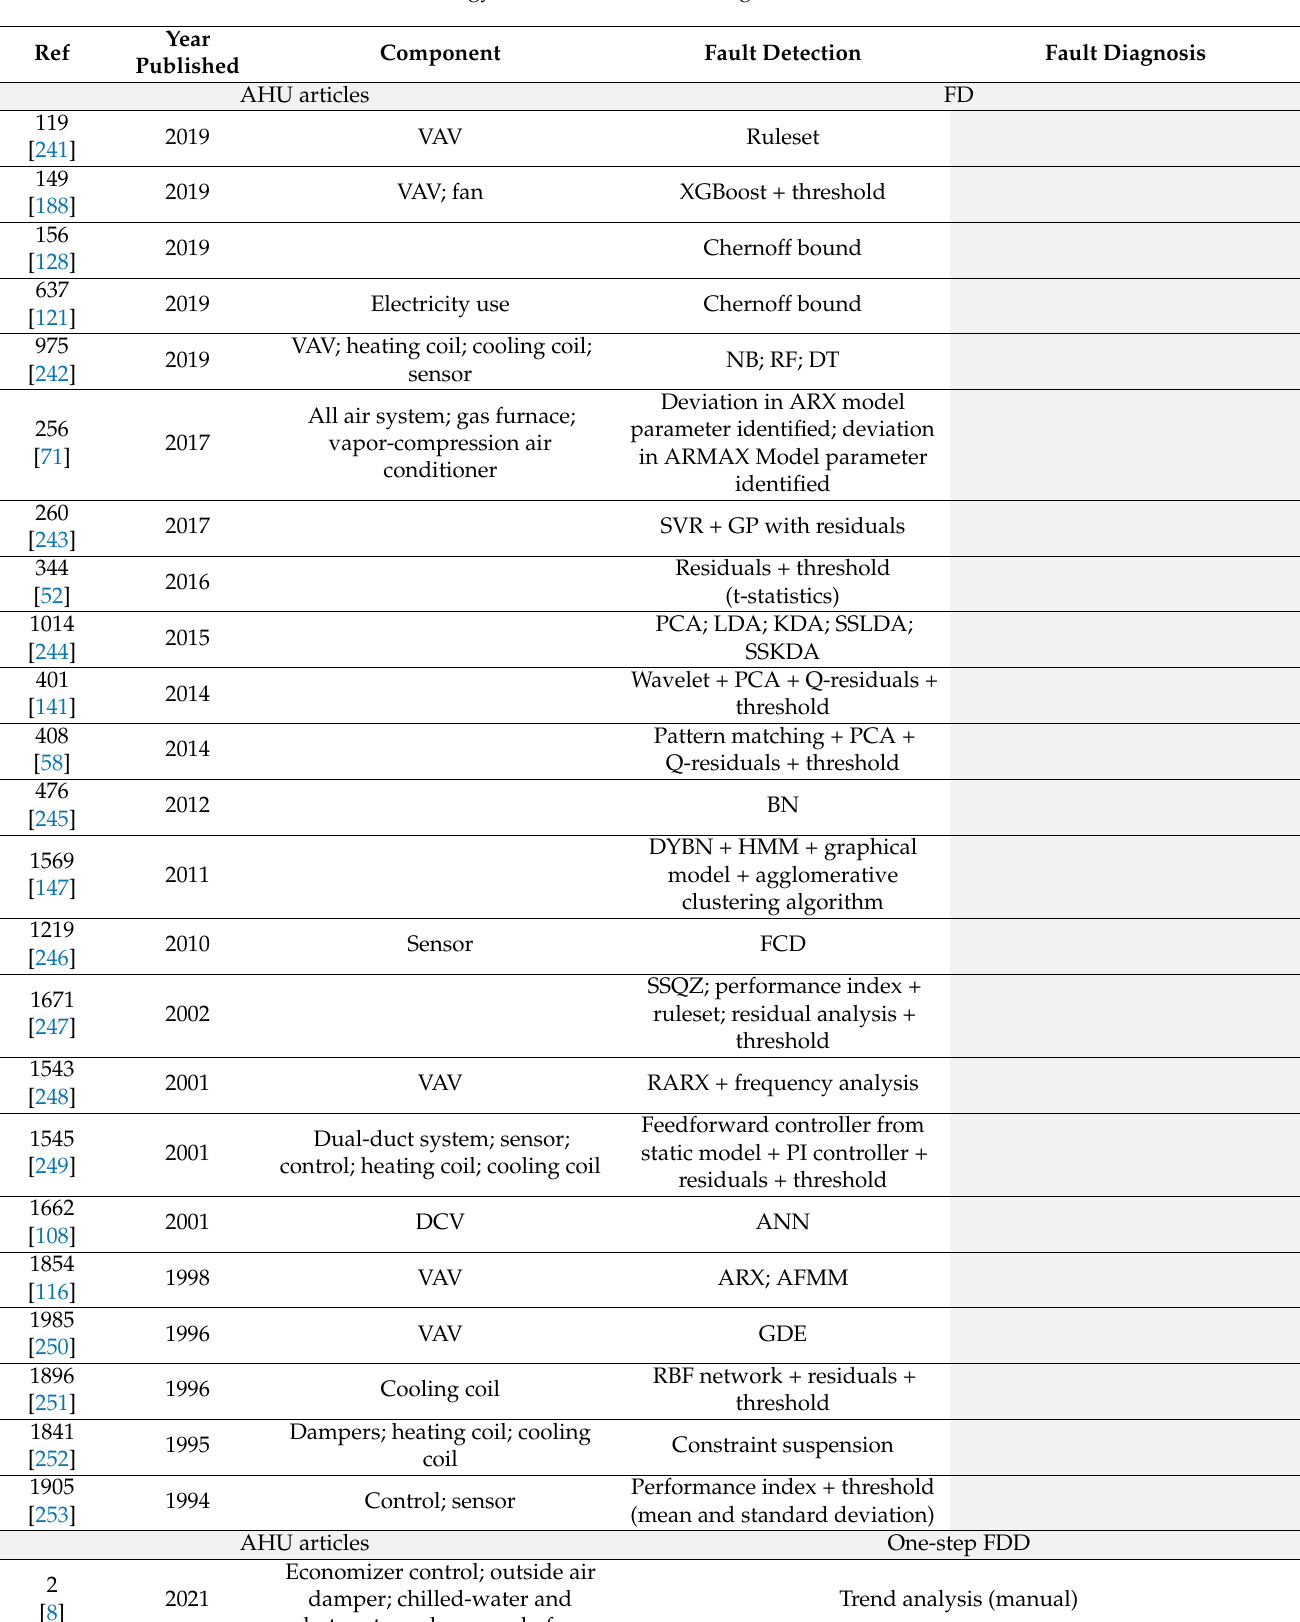
Table A4. Energy distribution: air-handling